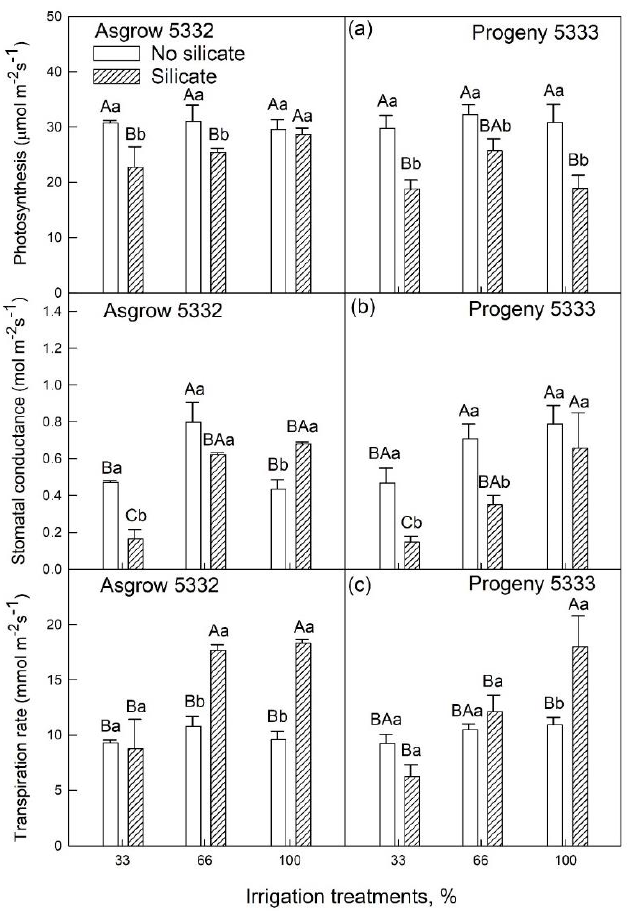
Figure 5. The influence of silicate application on two soybean cultivars’ ( a ) photosynthesis, ( b ) stomatal conductance, and ( c ) transpiration rate across three irrigation treatments, measured at 45 days after emergence of the seedling. The error bars correspond to standard error. The bars followed by the same letters (lower case letters within silicate and no silicate and upper-case letters within irrigation and silicate treatments) did not differ significantly at 5% by Tukey’s test.